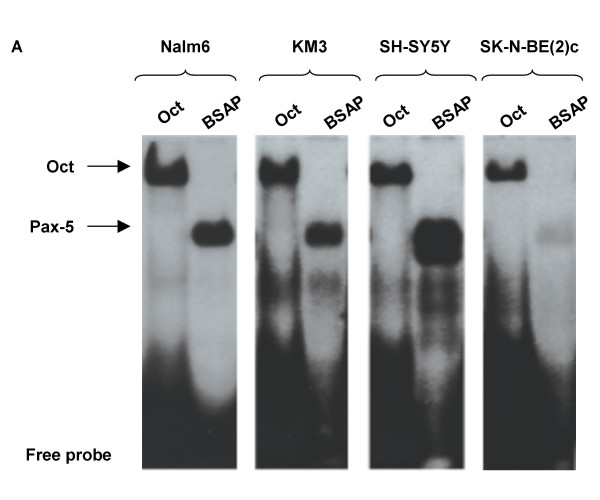
Neuroblastoma cells express constitutive levels of Pax-5 proteins.  Panel (A) display EMSAs where Oct or BSAP (Pax-5) binding sites was  incubated with nuclear extracts from Nalm6 (pre-B), KM3 (melanoma), SH-SY5Y  (neuroblastoma) and SK-N-BE(2)c (neuroblastoma) cells.